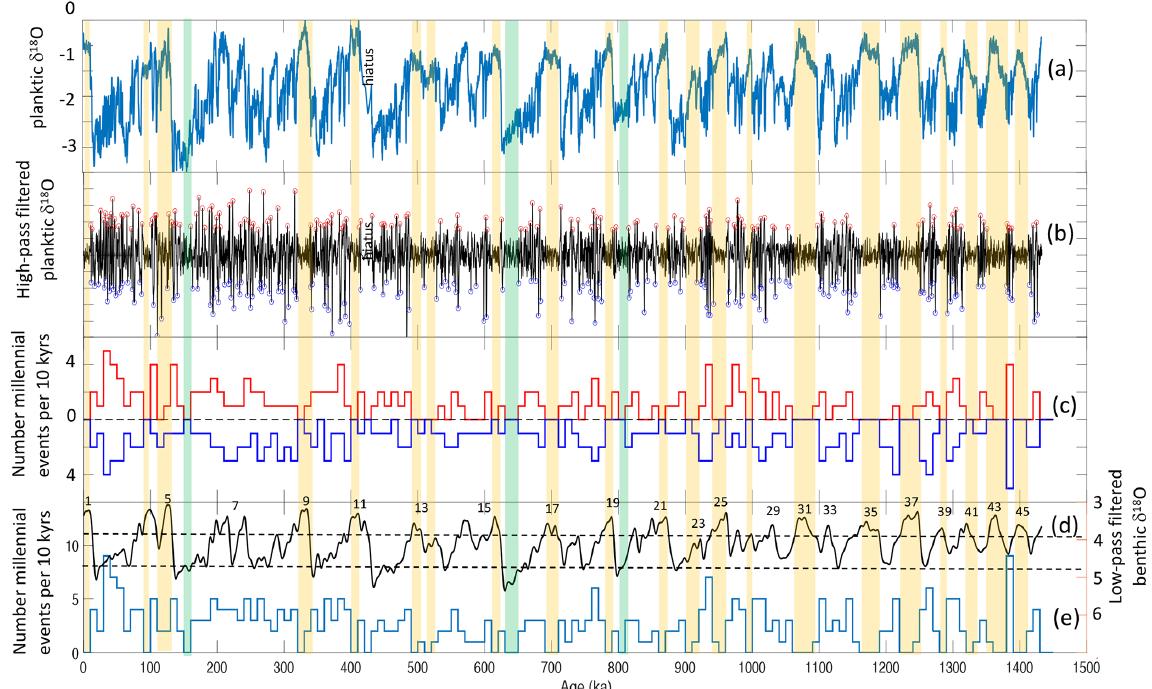
Figure 4. (a) The δ 18 O record of G. bulloides at Site U1385. (b) High-pass filter of (a) to remove orbital frequencies and to extract suborbital variability. Stadial (blue circles) and interstadial (red circles) events are identified by values that are greater than 1SD (standard deviation) from the mean. (c) The number of stadial (blue) and interstadial (red) events in non-overlapping windows of 10000-year duration. (d) Low- pass filter of benthic δ 18 O record (black) used to look up δ 18 O values for each millennial event. Horizontal dashed black lines correspond to the benthic δ 18 O thresholds marking the window of enhanced millennial variability. (e) The number of millennial events is the sum of the stadial and interstadial events in (c) . The orange shade indicates times when there are no millennial events per 10000 years associated with full interglacial stages. Green shade indicates where there are no millennial events per 10000 years associated with full glacial